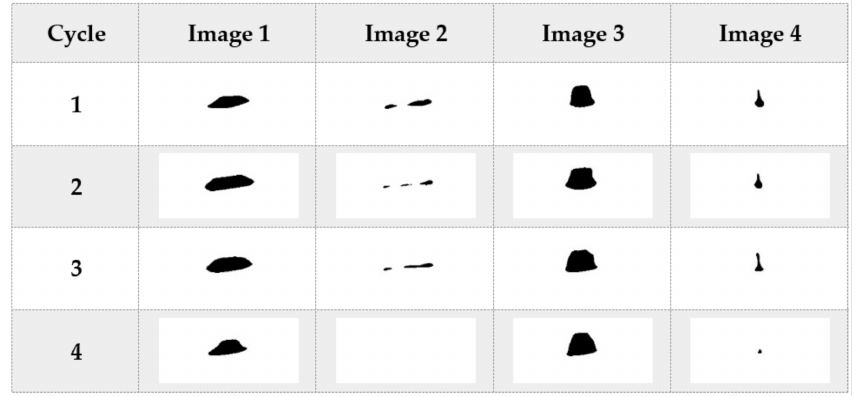
Figure 12. The repeated oscillatory pattern over 16 images (over 4 image cycles) of Sample 3 (Med) openings between 37–40 s of the test. Images 9385 to 9400 of 15,001 processed to display only colours 0 and 255. Threshold colour for opening is 51 with averaging